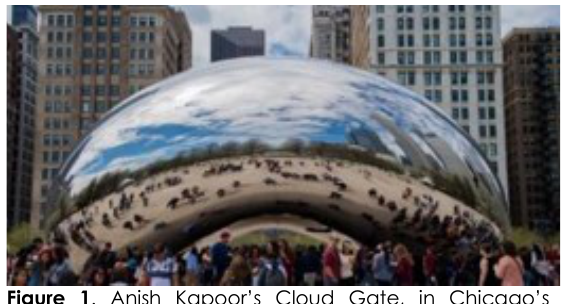
Figure 1 . Anish Kapoor’s Cloud Gate, in Chicago’s Millennium Park, 2004 [URL1; URL2] The city is described as an element representing the social and spiritual culture of society. Urban Table 1 : Classification of aesthetic, functional, and environmental criteria for urban space from the perspective of several researchers. Source Aesthetic Aspect of Urban Space Source Functional Aspect of Urban Space